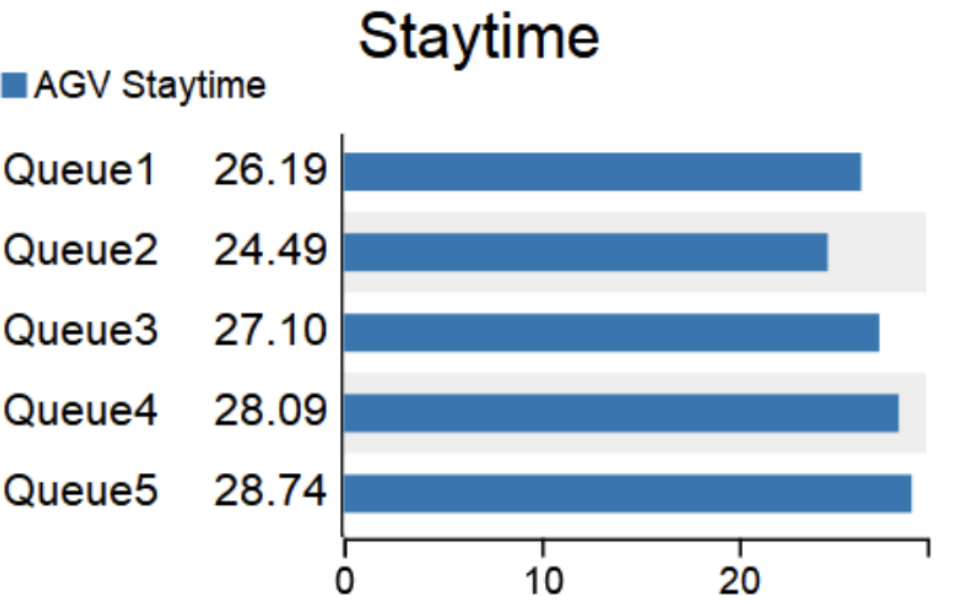
Figure 12. The queuing time of each picking station after dynamic selection